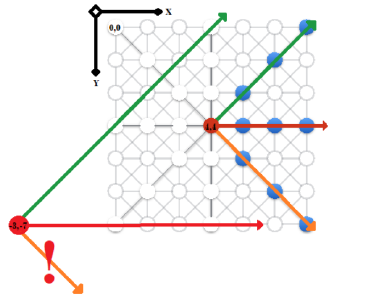
Figure 3. Problem: evaluation of nonexistent paths. Adapted from: (Drory et al.,